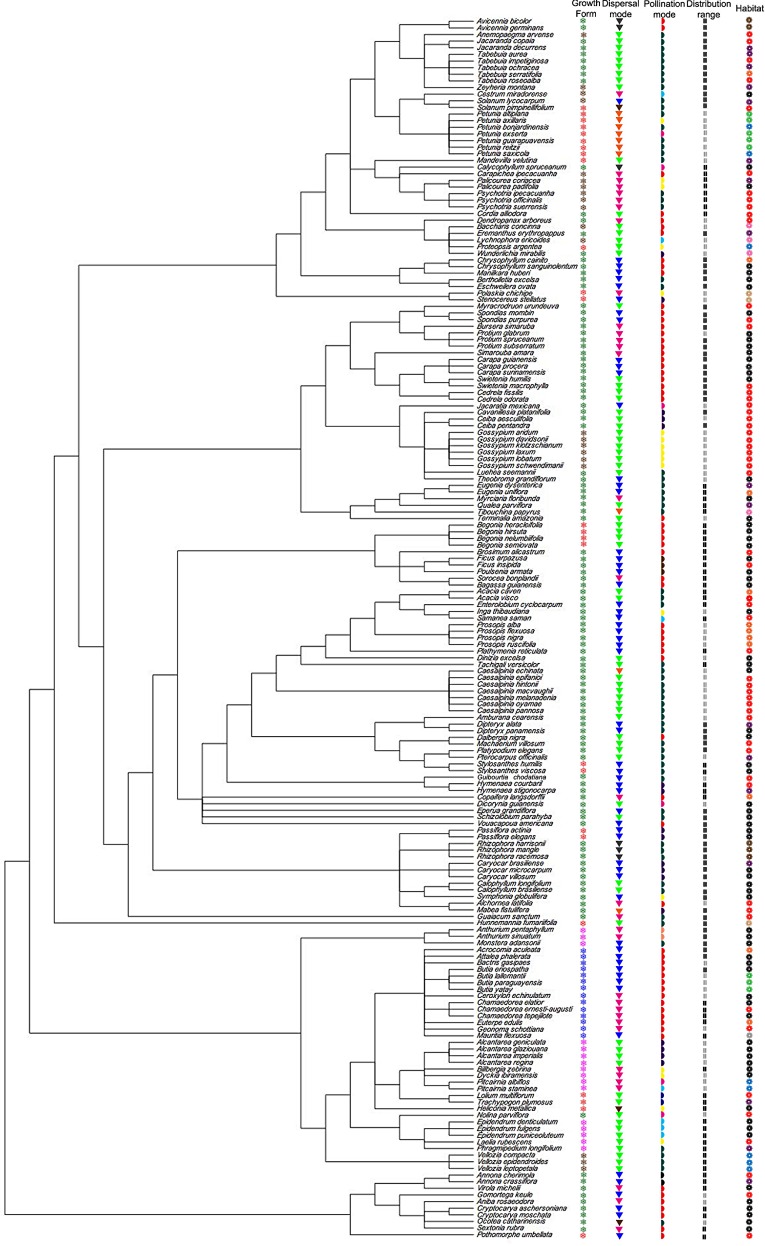
Phylogenetic super-tree of the Neotropical plants included in the analyses, obtained from Phylomatic using the internal master tree Phylomatic tree R20120829, with life-history traits and ecological attributes mapped.Growth form (❅): Fuchsia = Epiphytes, Red = Herbs, Blue = Palms, Brown = Shrubs, Green = Trees. Dispersal mode (▼): Orange = autochory, Brown = mixed (mammals and birds), Green = bats, Magenta = birds, Black = hydrochory, Dark blue = mammals, Light green = wind. Pollination mode (◗): Black = beetles, Yellow = birds, Brown = wasps, Red = small bees, Dark blue = wind, Purple = bats, Light blue = butterflies, Magenta = moth, Dark green = large bees, Light orange = flies. Geographical range (❙❙): Black = widespread, Grey = narrow. Habitat (❁): Sand = desert, Red = seasonally dry forests, Black = rainforests, Light green = grasslands, Brown = mangroves, Orange = mixed (rainforests and seasonally dry forests), Blue = rocky fields, Pink = rocky savannas, purple = savannas, Grey = wetlands. Reproductive system (❃): Brown = hermaphrodite, Dark blue = monoecious, Magenta = dioecious. Mating system (✭): Dark green = mixed, Dark red = outcrossing.